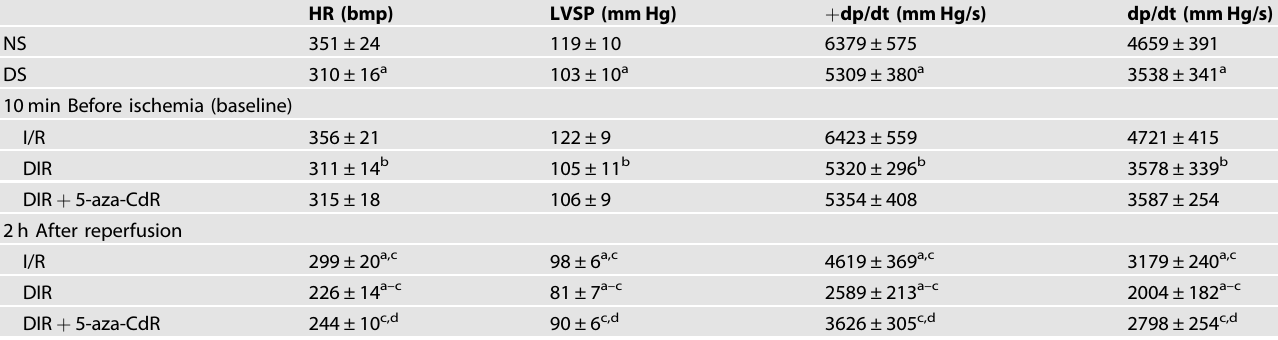
Table 3. Hemodynamic parameters at baseline after 2 h of reperfusion.